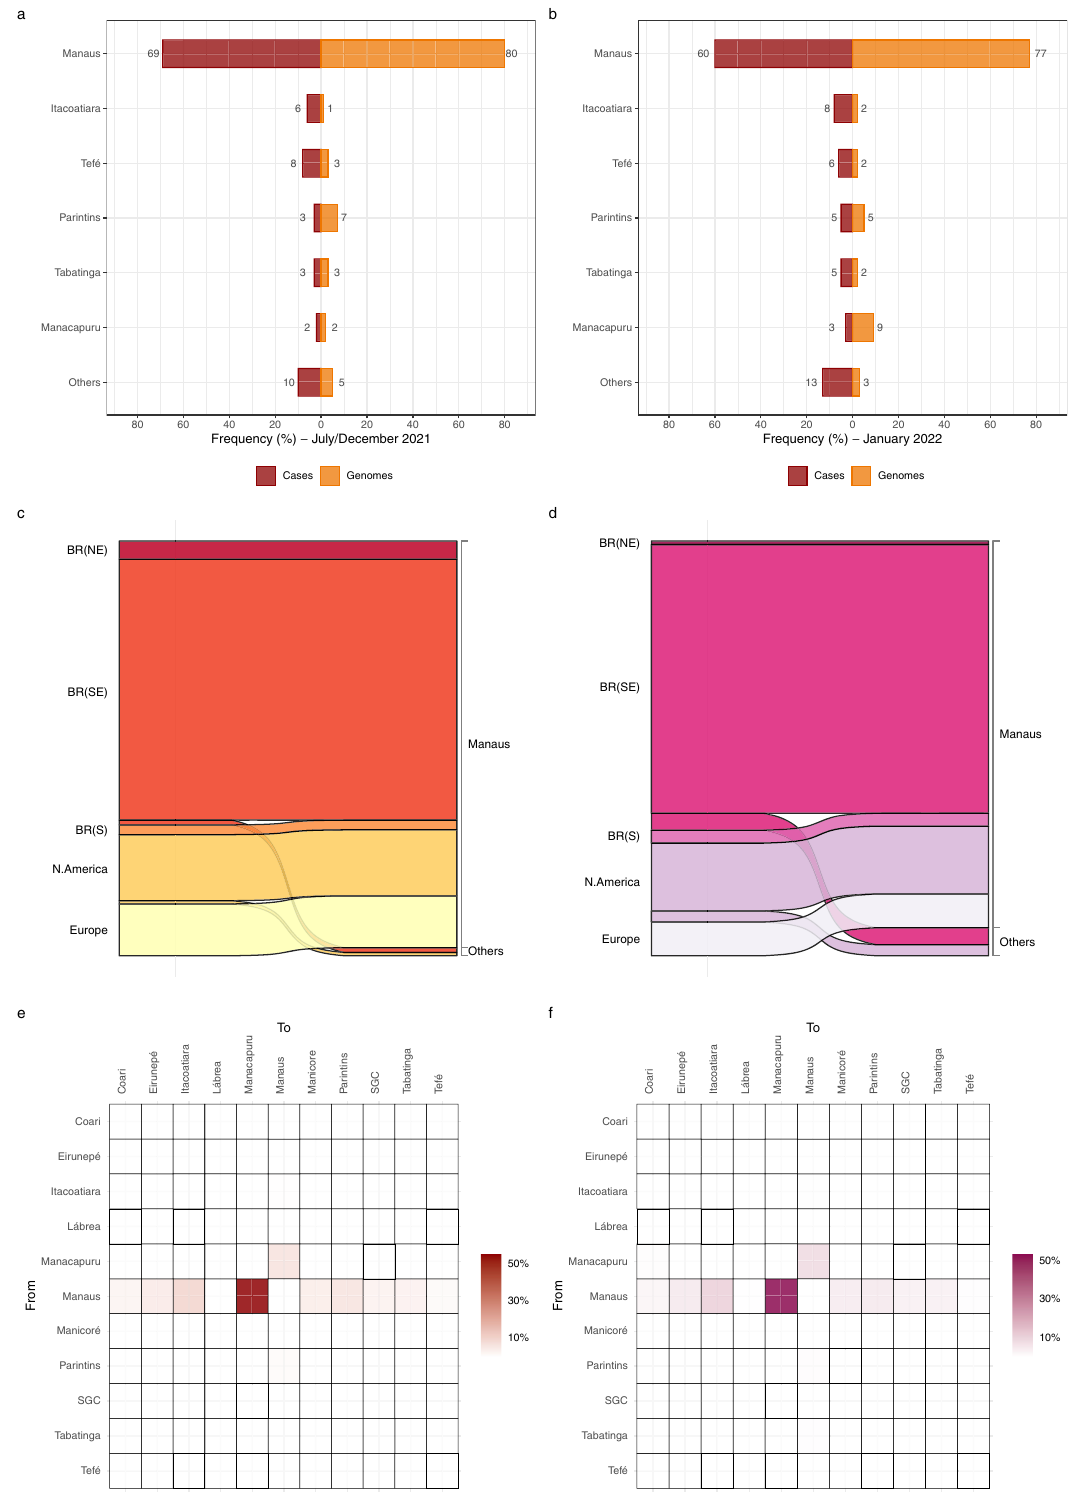
withthefulldataset( c )andasubsetproportionaltothecon fi rmednumberofcases per state region ( d ). e , f Heatmap cells are colored according to the estimated number of BA.1 lineage migrations between Amazonian regions inferred from the Bayesian phylogeographic analyses of the full dataset ( e ) and the subset ( f ). BR: Brazil, NE: Northeast, SE: Southeast, S: South, SGC: São Gabriel da